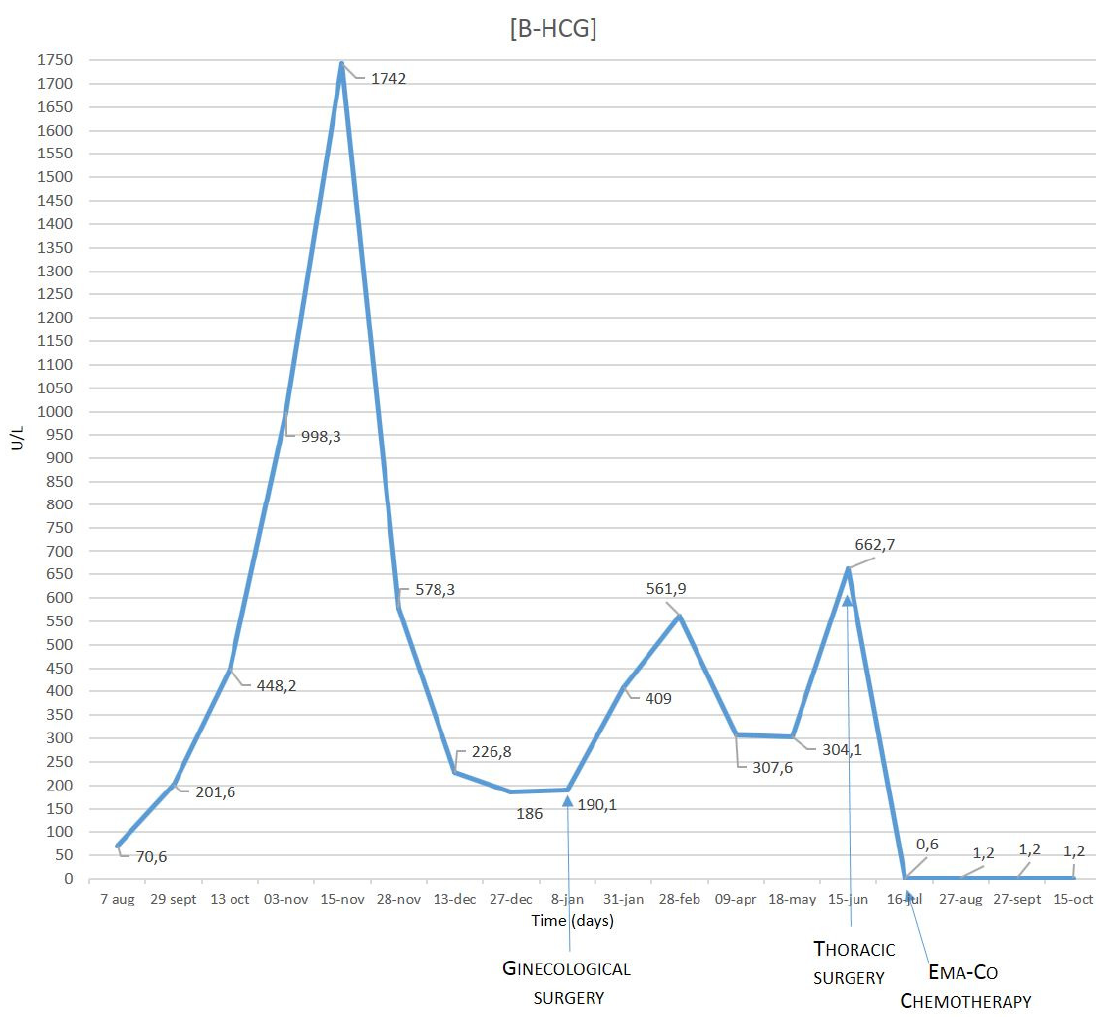
Figure 3. β -hCG level showed fluctuating concentrations during blood examinations.